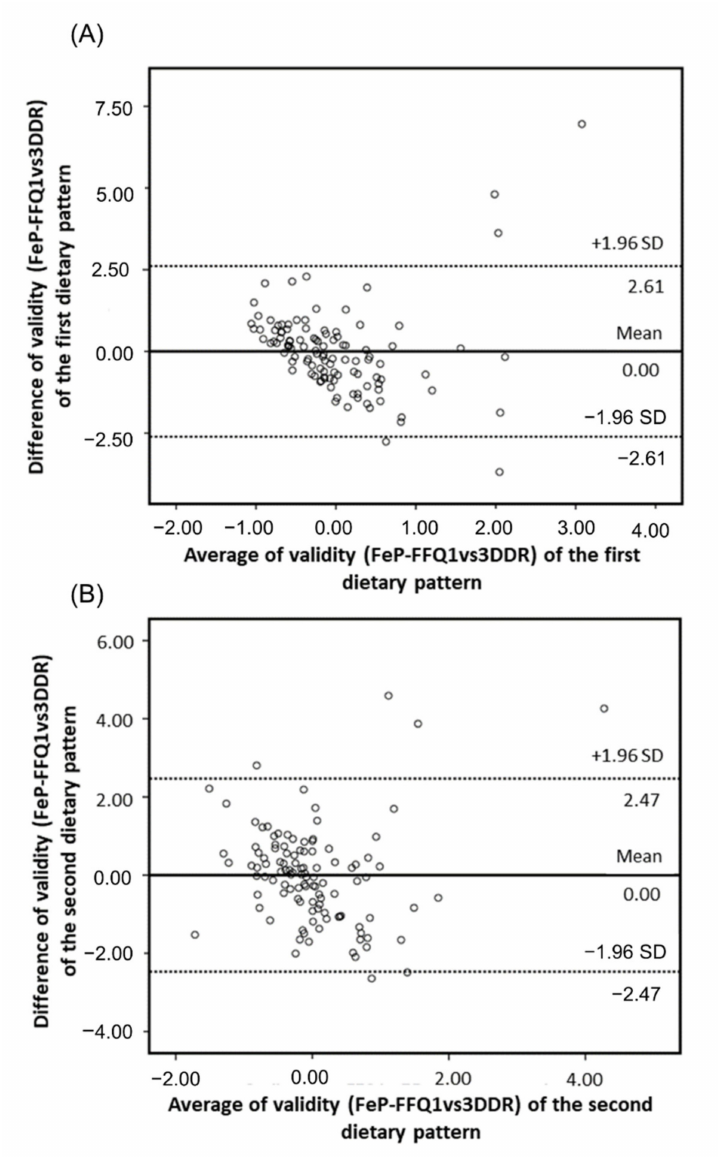
Figure 2. Bland–Altman plots for dietary patterns validity between FeP-FFQ1 and 3DDR: ( A ) “healthy” pattern agreement, ( B ) “industrialized food and dairy” pattern agreement. The solid line represents the mean difference, and the dotted lines represent the agreement limits (SD ±